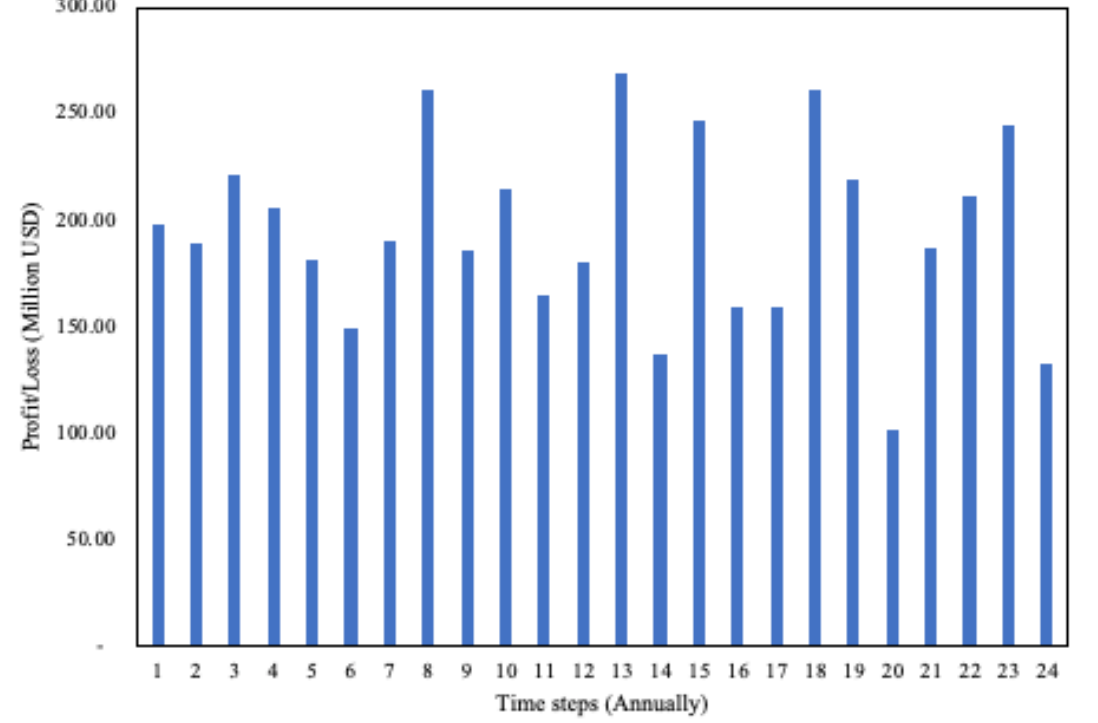
Figure 8. A single realisation of the cash flow series for baseline configuration BL–50.